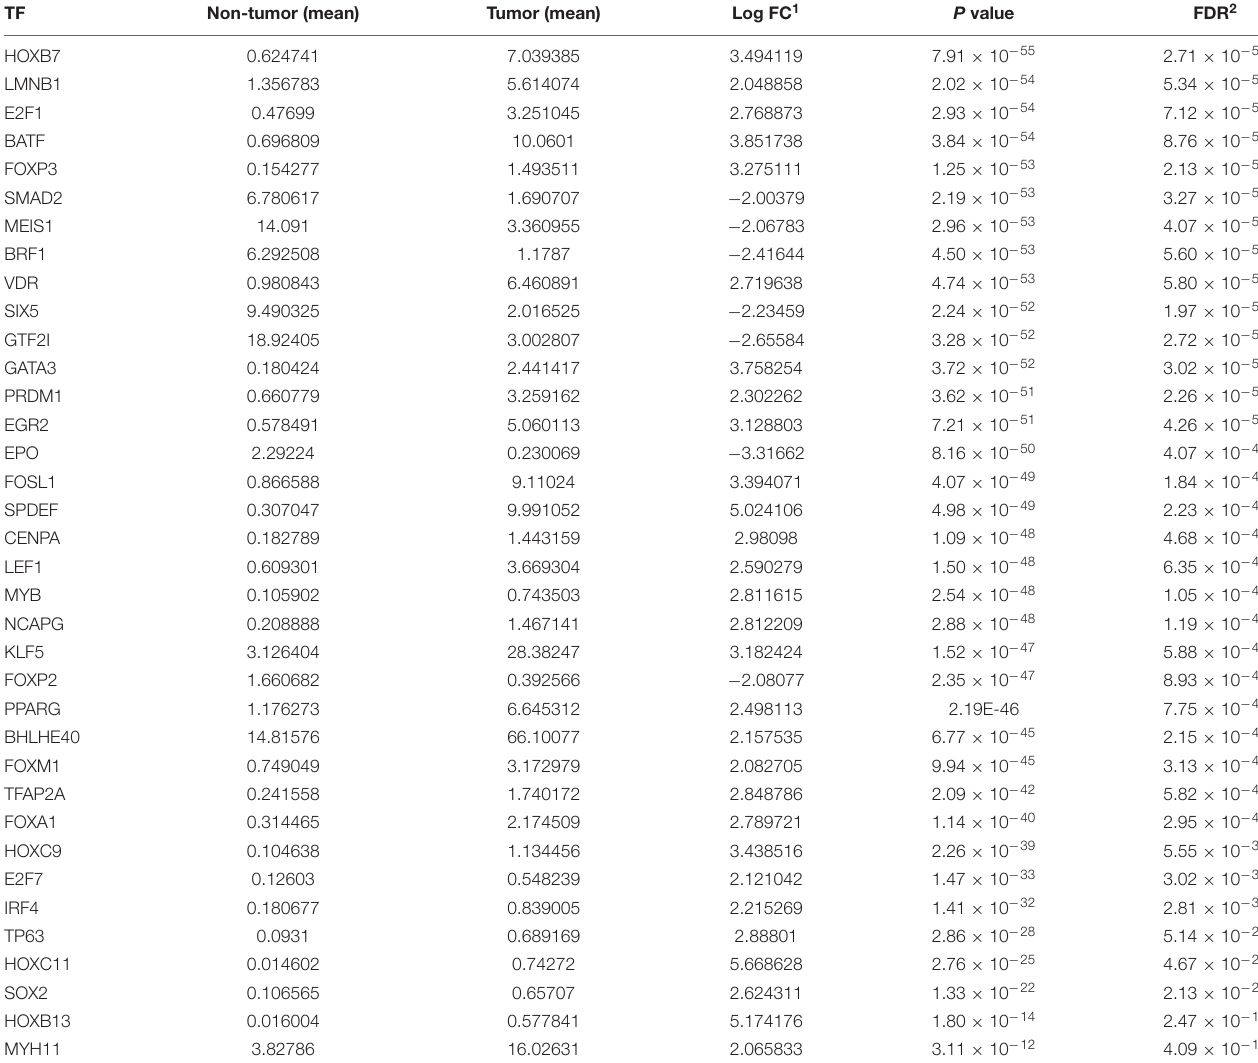
TABLE 2 | Differentially expressed transcription factors